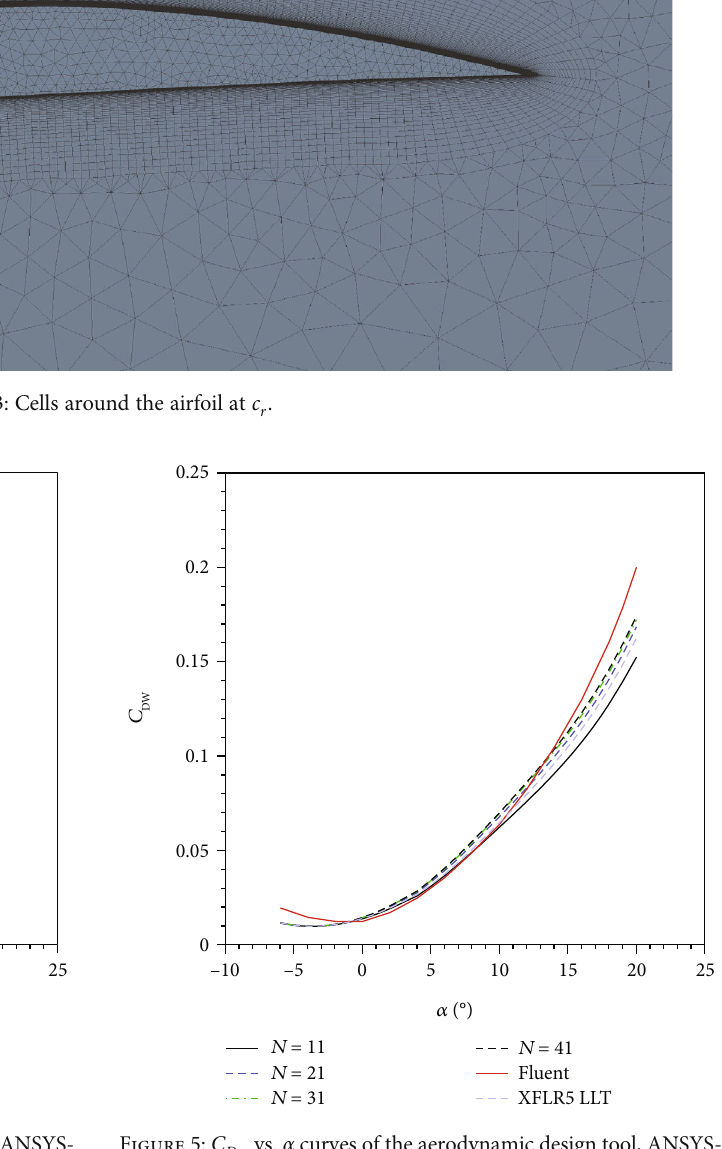
Figure 7. ANSYS-Fluent captures the transition location